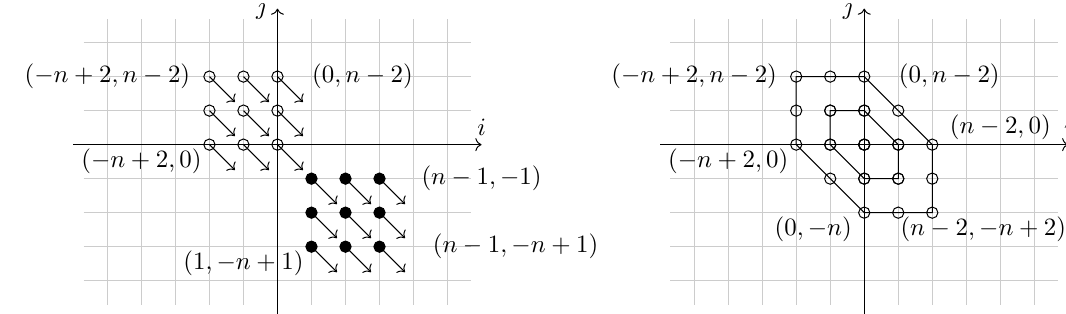
Figure 8 . Net result for the t 2 n -coe(cid:14)cient, n (cid:21) 0, after cancellations.